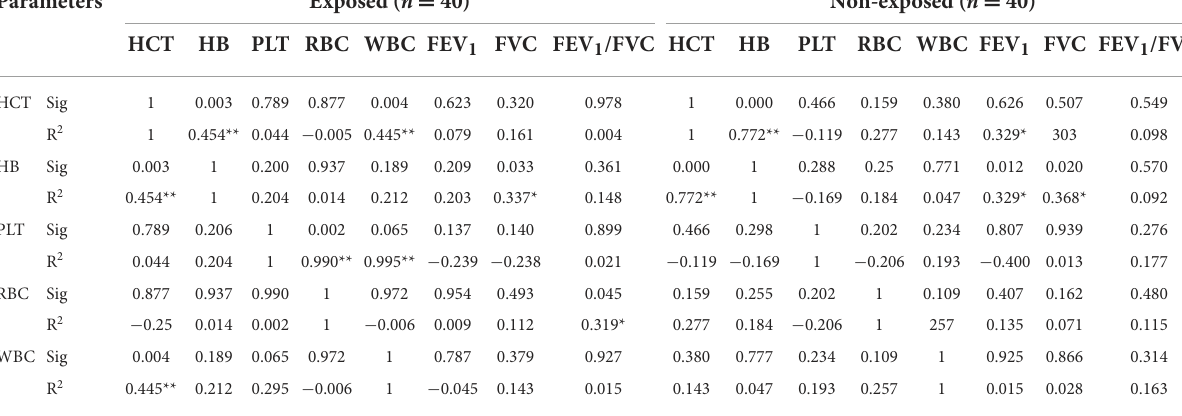
TABLE 5 Regression of blood and respiratory parameters in the exposed and non—exposed